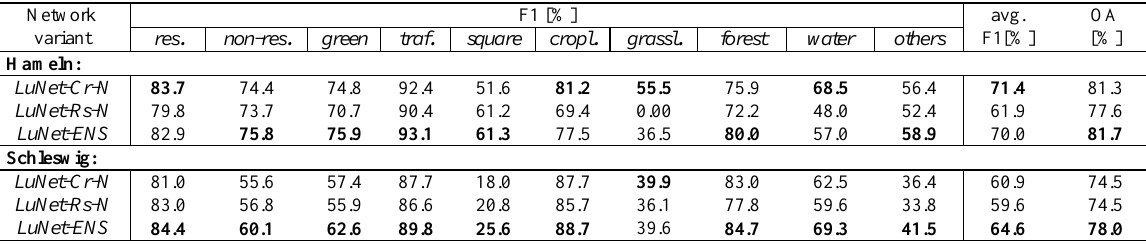
Results of land use classification. Network variant: cf. section 5.1.3. F1: F1 score, OA: Overall Accuracy, both evaluated on the basis of objects. Best scores are printed in bold